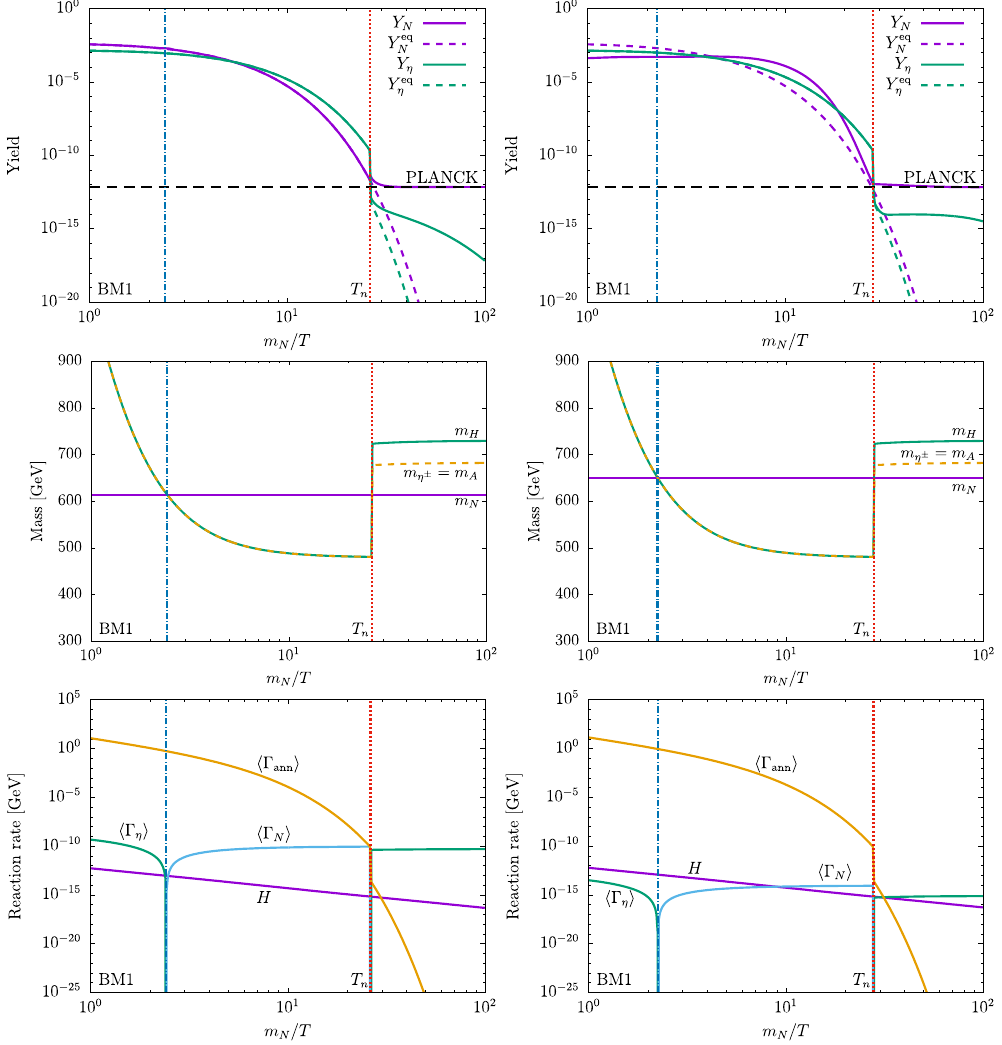
Figure 7 . Example solutions of the coupled Boltzmann equations (top), the scalar masses with thermal effects (middle), and the reaction rates (bottom) for the one-step PT (BM1) where the dark matter mass and the Yukawa coupling are fixed at ( m N , | Y | ) = (614 GeV , 1 . 00 × 10 − 5 ) for the left panels and (650 GeV , 8 . 20 × 10 − 8 ) for the right panels, respectively.